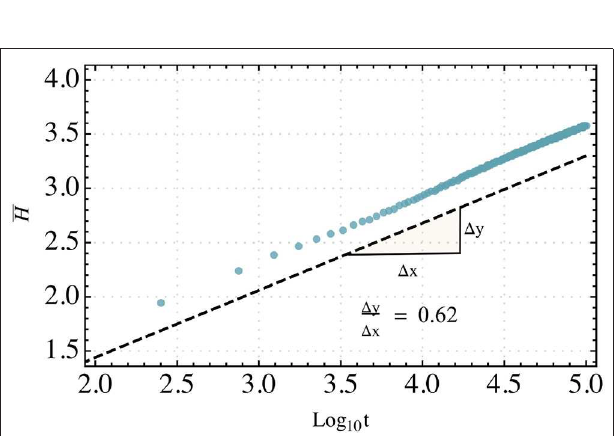
FIGURE 3 | Averaged entropy H shown in semi-log scale. The entropy grows with a linear slope of α = 0.62. Since the entropy of the three different initial positions may vary at short times we have ignored the first 20 % of the datapoints when performing the linear fit. The slope α = 0.62 is in good agreement with the expected minimum spanning tree